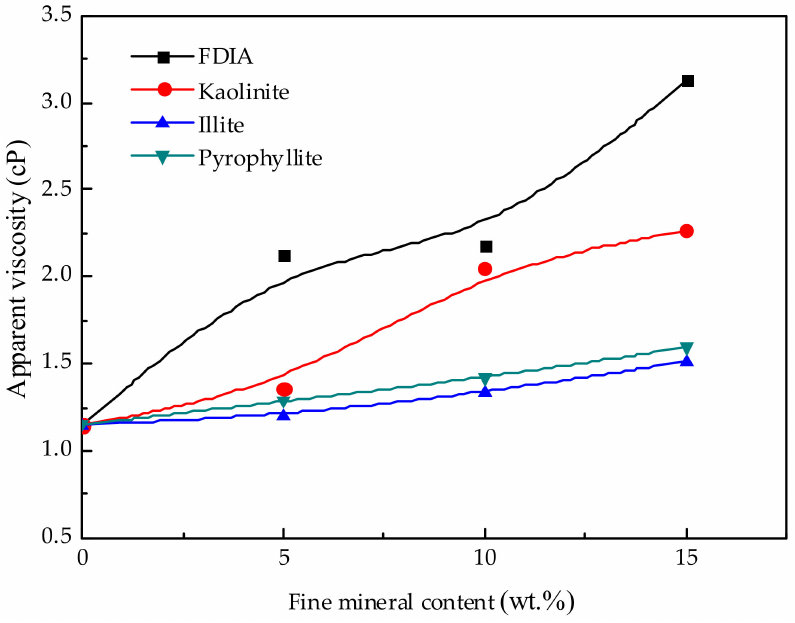
Figure 8. E ff ect of fine mineral addition on apparent viscosity at shear rate of 100 s −